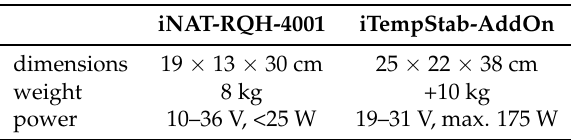
Table 1. Technical specifications of the iNAT-RQH-4001 IMU and the additional temperature stabilisation box (iTempStab-AddOn). Notice that the IMU fits inside the temperature box, which adds